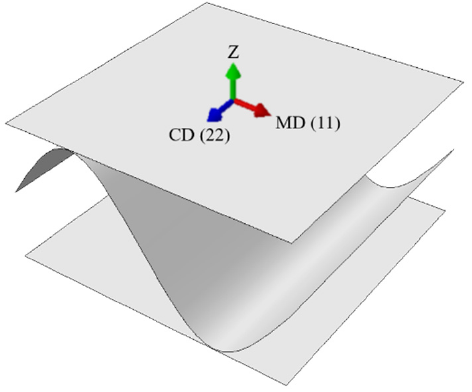
Figure 2. Material orientation.